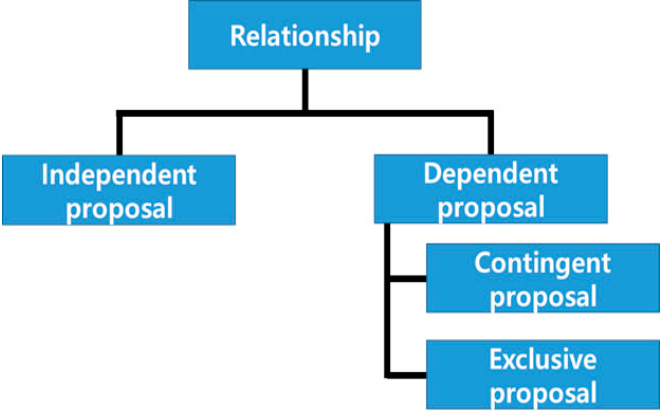
Figure 3. Relationship between flood prevention measures.